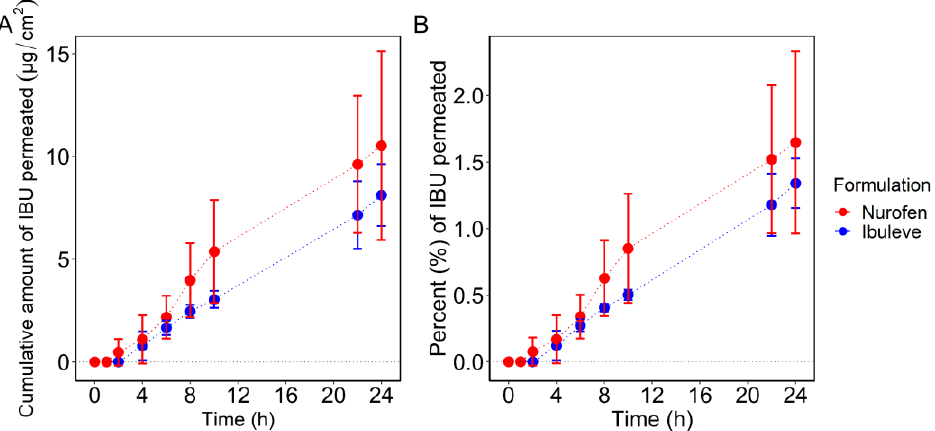
Figure 1. Permeation profiles of IBU over time for the commercially available formulations, Ibuleve and Nurofen, in human epidermis, expressed as ( A ) cumulative amounts ( µ g/cm 2 ) and ( B ) percent- ages (%) of the dose applied ( n = 5; mean ± SD).